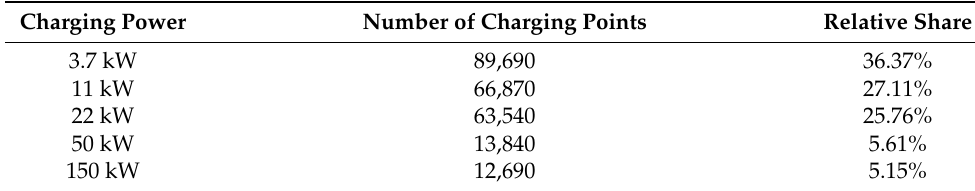
Table 8. Charging points per power of the mid-front